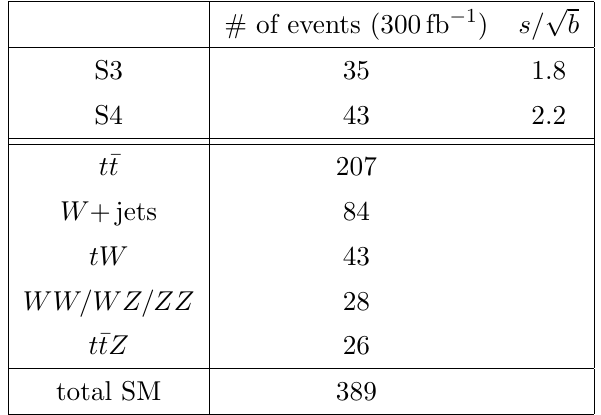
Table 3 . Number of events of signal and backgrounds and the corresponding s= the selection cuts for the 1 b 1 ‘ + E miss